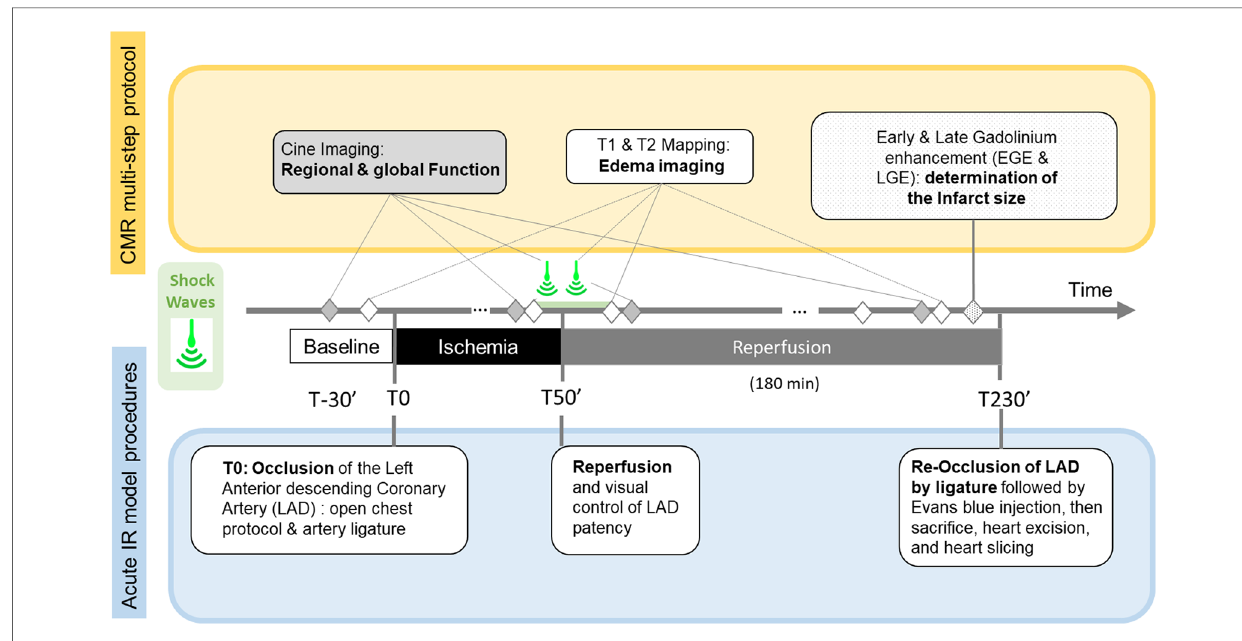
FIGURE 1 Timeline of the Cardiac Magnetic Resonance (CMR) multi-step protocol (top), Shock-Wave (SW) therapy time points, and acute Ischemia/Reperfusion (IR) open chest swine model stages.